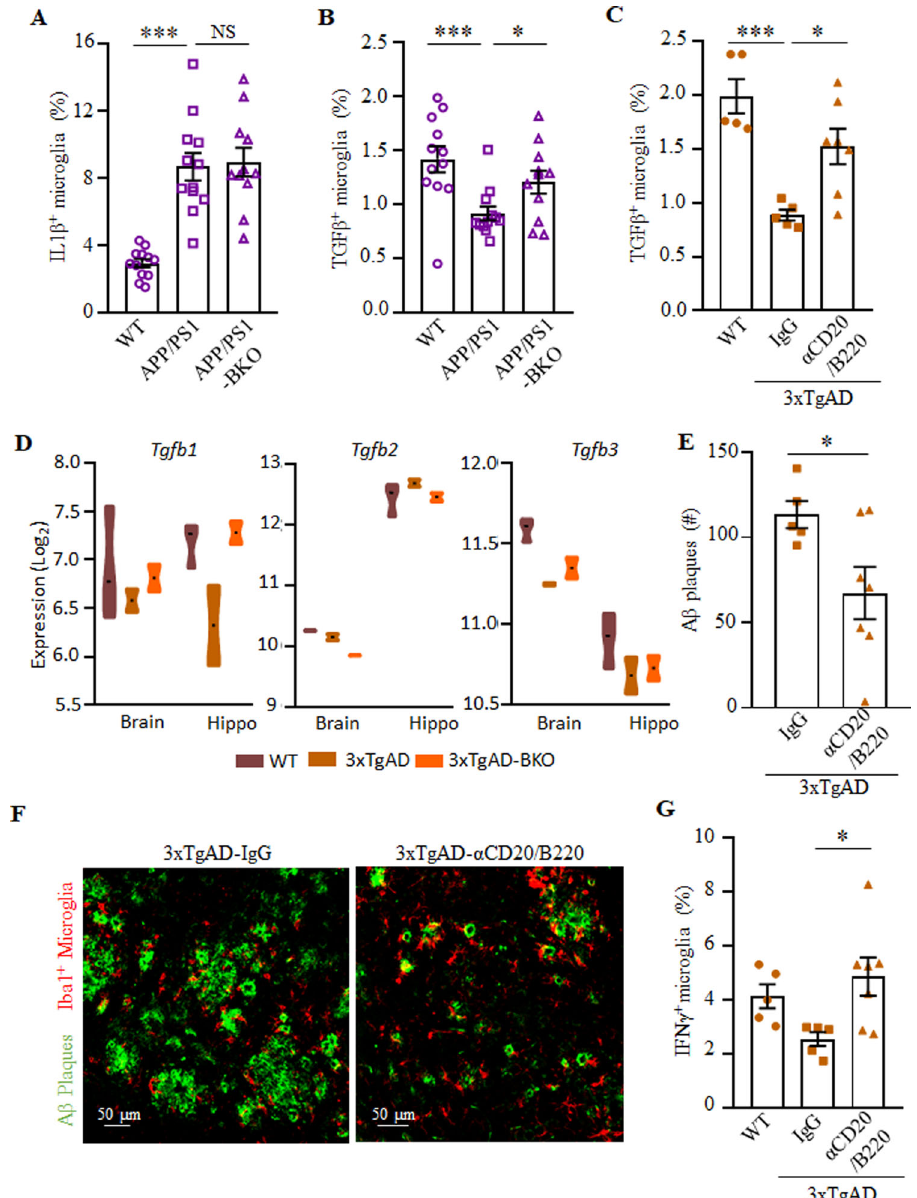
Fig. 4 B-cell de fi ciency at least in part reversed the DAM phenotype. The results of fl ow cytometric quanti fi cation of IL1 β + ( A ) and TGF β + ( B , C ) microglia (CD11b + CD45 int ) in the brains of indicated mice ( n = 11 – 12) are shown. Genetic B-cell de fi ciency in APP/PS1 mice (APP/PS1-BKO, B ) or transient depletion of circulating B cells (aCD20/B220, C ) at the onset of AD (70 – 79 weeks of age 3×TgAD mice) reversed the AD-associated decrease of TGF β + microglia. mRNA microarray analyses of hippocampi and brains (without hippocampus) of 3×TgAD mice revealed that the B-cell de fi ciency (3×TgAD- BKO) upregulates expression of TGF β 1, but not TGF β 2 and TGF β 3 ( D , n = 3). Therapeutic depletion of B cells (aCD20/B220) at the onset of AD ameliorated AD ( E – G ), as it markedly decreased A β plaques in the subiculum (quanti fi cation and representative images are shown in E and F , respectively; A β plaque (green) and Iba1 + microglia (red, F ), n = 6 – 8; independently reproduced twice). B-cell depletion reversed the reduction of IFN γ + microglia in 3×TgAD mice ( G , n = 5 – 7). Mean ± SEM is shown; each symbol is for a single mouse. Gating strategy is shown in Supplementary Fig. 9B. * p <